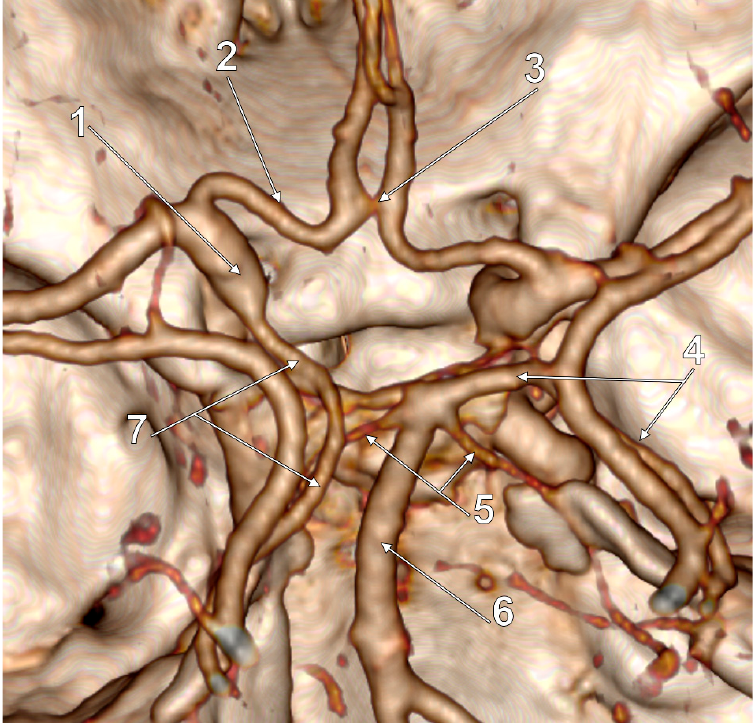
Figure 3. Postero-superior view of the cW. Unilateral full/complete FPCA (f-FPCA). Two variant sides of the cW: aplastic left P1 and aplastic right PComA. 1. Left ICA; 2. A1 segment of the left ACA; 3. AComA; 4. Right PCA (P1+P2); 5. Superior cerebellar arteries; 6. BA; 7. Left f-FPCA.